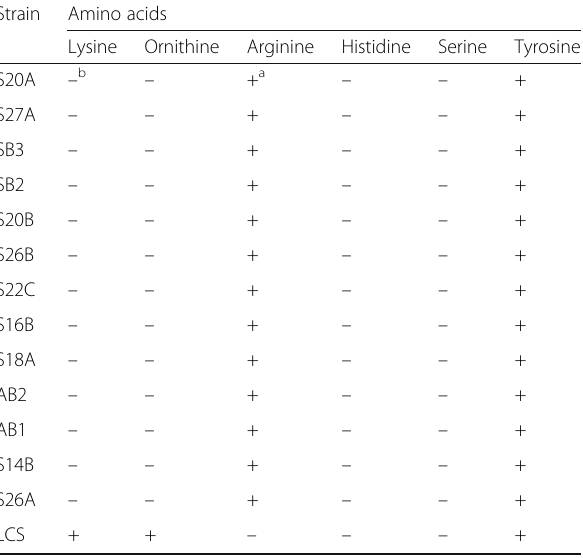
Table 3 Detection of biogenic amines